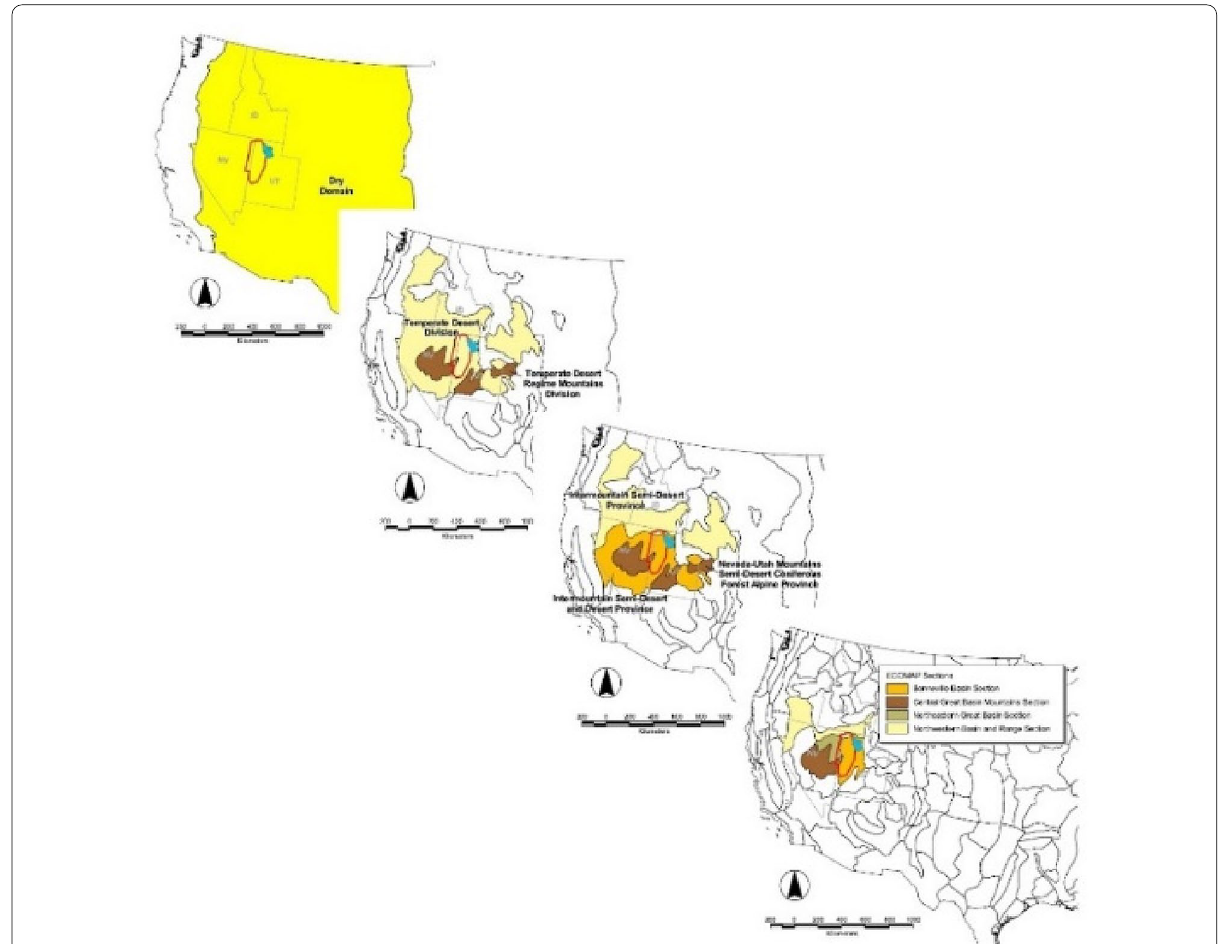
Fig. 2 Upper four levels’ Domain, Division, Province, and Section in the study